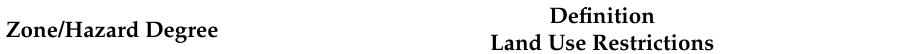
Table 1. Synthesis of the AINEVA criteria [31] for the delimitation and the use of areas with different degrees of exposure to avalanche hazards (T = return time of the avalanche (years) and P imp = impact pressure (kPa)). Definition Zone/Hazard Degree Land Use Restrictions Areas affected either by avalanches with T = 30, even with low RED destructive power (P imp ≥ 3), or by highly destructive avalanches High Hazard (P imp > 15) with T = 100. New constructions are not allowed. Areas affected either by avalanches with T = 30 with low destructive power (P imp < 3) or areas affected by rare events (T = 100) with a BLUE moderate destructive power (3 < P imp < 15). New constructions are Moderate Hazard allowed but with strong restrictions (low building indexes, reinforced structures, etc.). Areas affected either by events with a low destructive power (P imp < 3) YELLOW and T = 100 or by events with 100 < T < 300. New constructions are Low Hazard allowed, with minor restrictions (no public facilities, like schools, hotels,